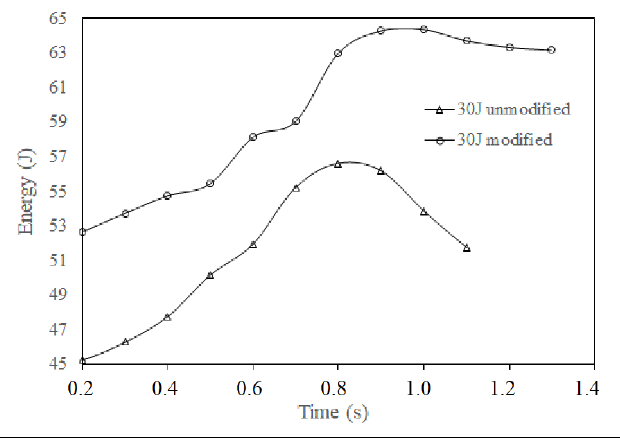
Figure 29. Comparison of energy absorbed by impacts of weight drop test.